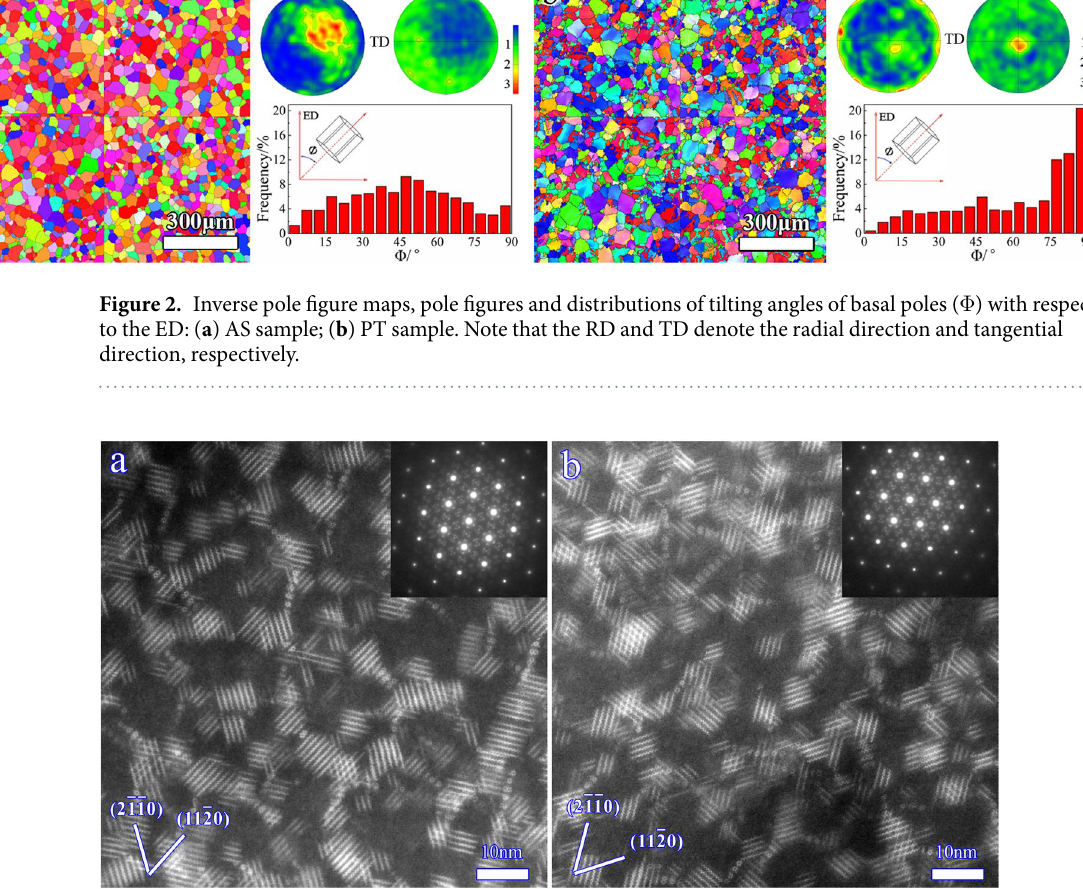
of a Mg AZ31 15–17 . Considering that addition of Gd might promote the activity of prismatic slip 18 , the CRSS ratio of 1:1:1.5 for basal slip (10 MPa): {1012} twinning (10 MPa): prismatic slip (15 MPa) was used in this study. As seen in Fig. 4, the dominant mode is {1012} twinning with Φ below 22°, basal slip with Φ between 22° and 74° and prismatic slip with Φ over 74°. In addition, the activation stress for prismatic slip is generally higher than that for basal slip and {1012} twinning. Obviously, the dominant deformation mode and its activation stress are highly dependent on Φ . The fraction of grains favorable for basal slip, prismatic slip, and {1012} twinning during tension along the ED within the two samples was calculated using the same CRSS ratio, and the results are listed in Table 2. For each sample, approximately 900 grains were used for this calculation. The fraction favoring basal slip is up to 69% in AS sample, while only about 41% in PT sample. In stark contrast, the fraction favoring prismatic slip in AS sample (15%) is greatly lower than that in PT sample (49%). As the activation stress for prismatic slip is higher than that for basal slip, the inclination of basal poses toward the direction perpendicular to the ED will enhance the yield strength during tension along the ED. Different from uniaxial tension, there exists a more complex stress state in Vickers hardness test. As shown in Fig. 5a, the indenter has four pyramidal planes (labeled as 1, 2, 3, 4), each side of which will exert a compressive stress ( σ , normal to the pyramidal plane surface) and a shear stress ( τ , parallel to the pyramidal plane surface) onto the sample 19 . Our simulation shows that the σ / τ near the identention surface is approximately 2:1. This ratio is similar to that predicted by Prasad et al . 19 . To determine the dominant deformation mode as a function of Φ during hardness tests, we also calculated the CRSS/SF for basal slip, {1012} twinning and prismatic slip. However, the form of Schmid law under multi-axial stress state is different from that under an uniaxial stress state 20, 21 . For example, both the tensile stress parallel to the rolling direction and compressive stress along the normal direction are incorporated in the calculation of the SF under rolling condition 21 . Following this method, the SF for hardness tests considering both the compressive stress and shear stress is calculated using the following formula: m cos cos cos cos (1) α β φ ϕ = − where α / φ is the angle between the shear stress/compressive stress and the slip plane normal, and β / ϕ is the angle between the shear stress/compressive stress and the slip direction. 3 Scientific RepoRts | 7: 8647 | DOI:10.1038/s41598-017-08966-z